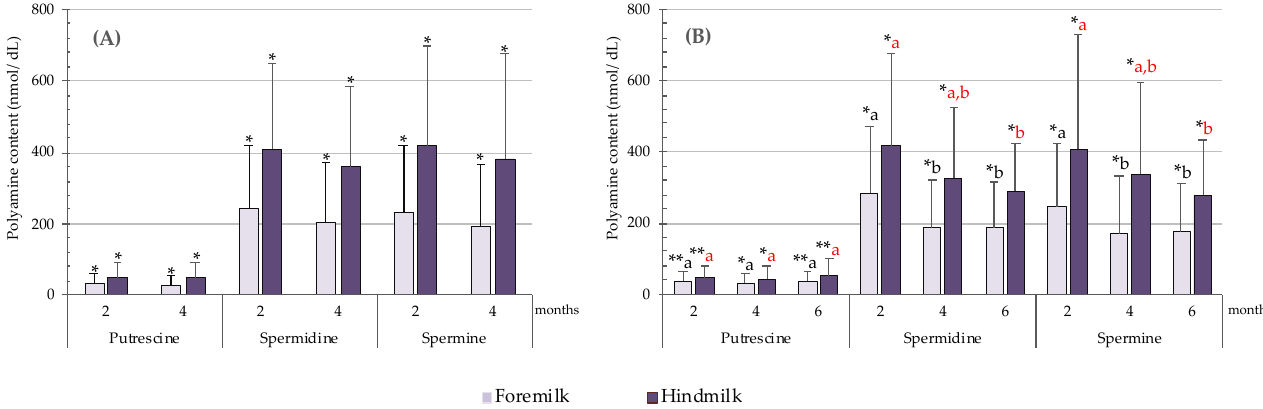
Figure 3. Putrescine, spermidine, and spermine contents (nmol/dL) in foremilk and hindmilk at two and four months of breastfeeding ( n = 83) ( A ) and during the first six months of breastfeeding ( n = 33) ( B ). Wilcoxon test was used to compare the polyamine contents between foremilk and hindmilk ( A , B ) and along the breastfeeding process ( B ). Asterisks indicate differences between foremilk and hindmilk (* p < 0.001 and ** p < 0.01). Different letters in black indicate statistically significant differences between lactation months for foremilk samples and letters in red indicate differences in hindmilk samples. For spermidine, p = 0.010 for foremilk 2 vs. 4 months, p = 0.010 for foremilk 2 vs. 6 months, and p = 0.006 for hindmilk 2 vs. 6 months. For spermine, p = 0.009 for foremilk 2 vs. 4 months, p = 0.049 for foremilk 2 vs. 6 months, and p = 0.015 for hindmilk 2 vs. 6 months.